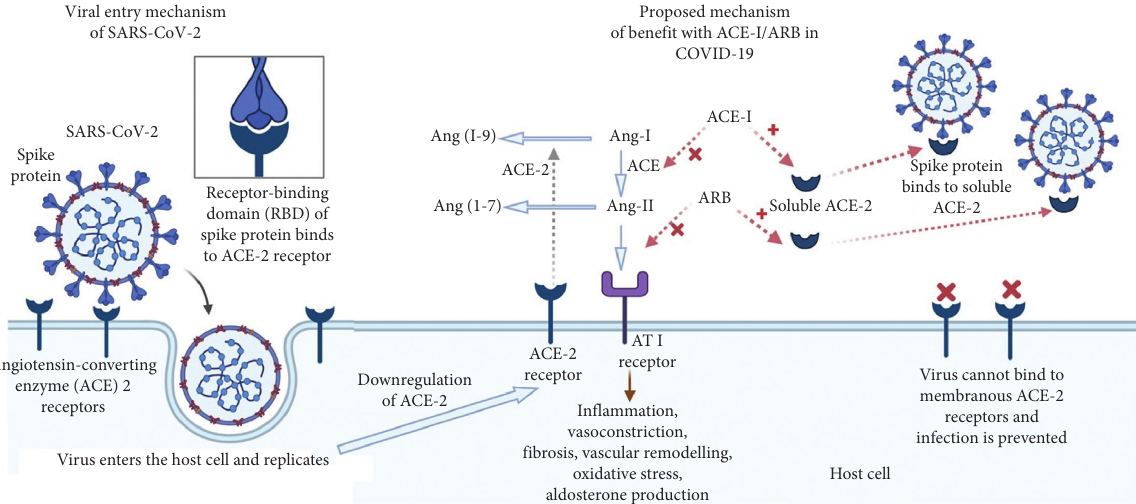
Figure 2: The interplay between RAS (renin-angiotensin system) and COVID-19 (coronavirus disease 2019). SARS-CoV-2 (severe acute respiratory syndrome coronavirus-2) enters the host epithelial cell after its spike protein’s receptor-binding domain binds to the membrane- bound ACE-2 (angiotensin-converting enzyme-2) receptor. The cellular entry is followed by endocytosis and further viral replication and subsequent release. SARS-CoV-2, after entry inside the cell, causes downregulation of further ACE-2 expression. ACE-2 is responsible for the conversion of Ang (angiotensin) II to Ang (1–7) and Ang-I to inactive Ang (1–9). The downregulation of ACE-2 results in an unopposed action of Ang-II through its AT1 (angiotensin II type 1) receptor. ACE-I (angiotensin-converting enzyme inhibitor) and ARB (angiotensin receptor blocker) oppose Ang-II’s action by blocking its synthesis and receptor, respectively. ACE-I/ARB may also cause overexpression of the soluble form of ACE-2, which intercepts the binding of SARS-CoV-2 with membrane-bound ACE-2, thus inhibiting the viral entry into the host